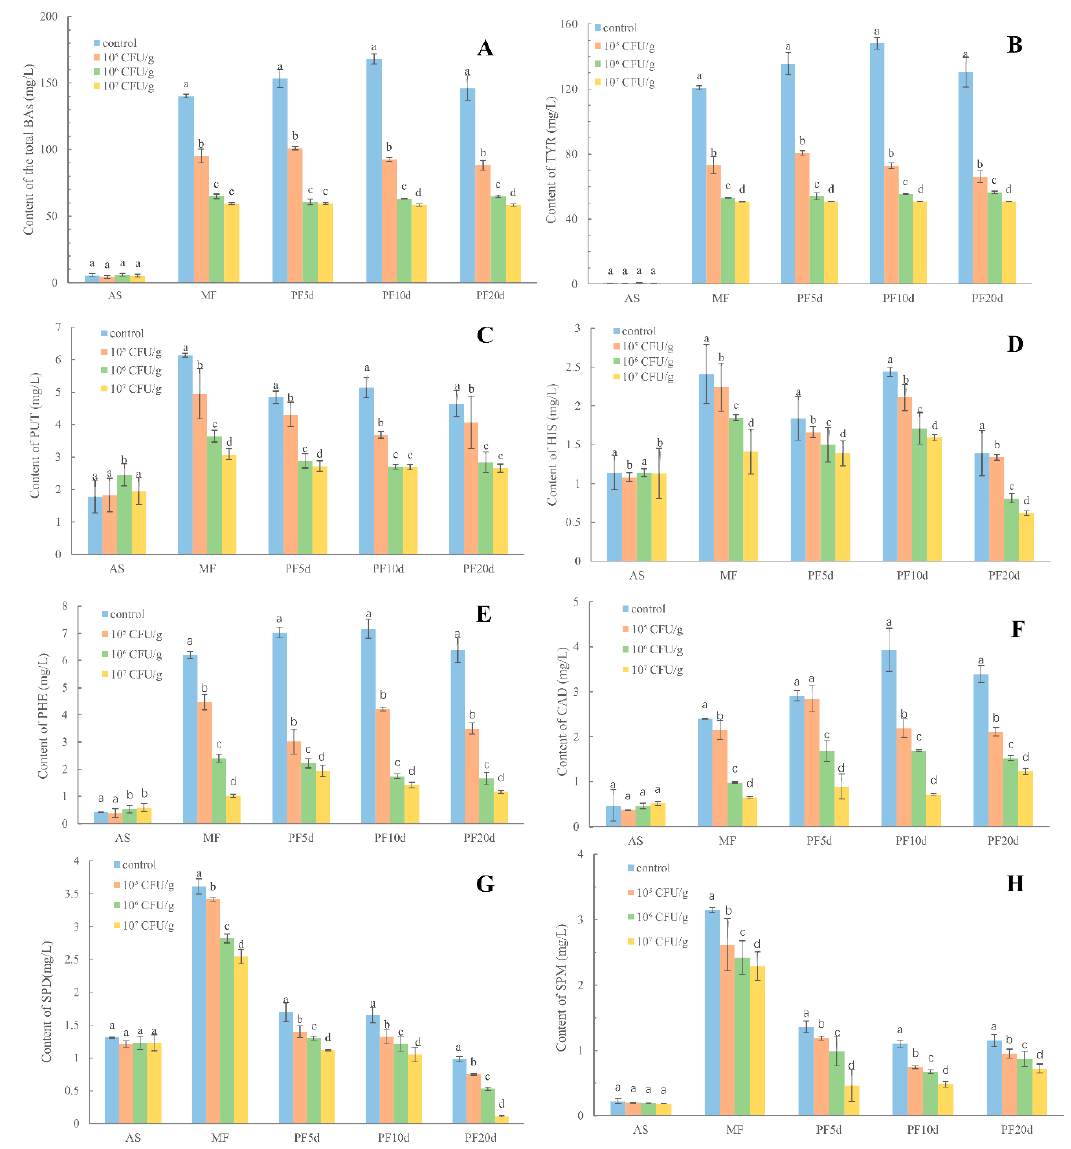
Figure 3. The contents of the total biogenic amines (BAs, A ), tyramine (TYR, B ), putrescine (PUT, C ), Histamine (HIS, D ) phenylethylamine (PHE, E ), cadaverine (CAD, F ), spermidine (SPD, G ) and spermine (SPM, H ) in Chinese rice wine adding different level of L. plantarum CAU 3823 at the post-fermentation and main fermentation stage during different fermentation stages (addition of starter (AS); main fermentation (MF); post-fermentation 5d (PF5d); post-fermentation 10d (PF10d); post-fermentation 20d (PF20d)).